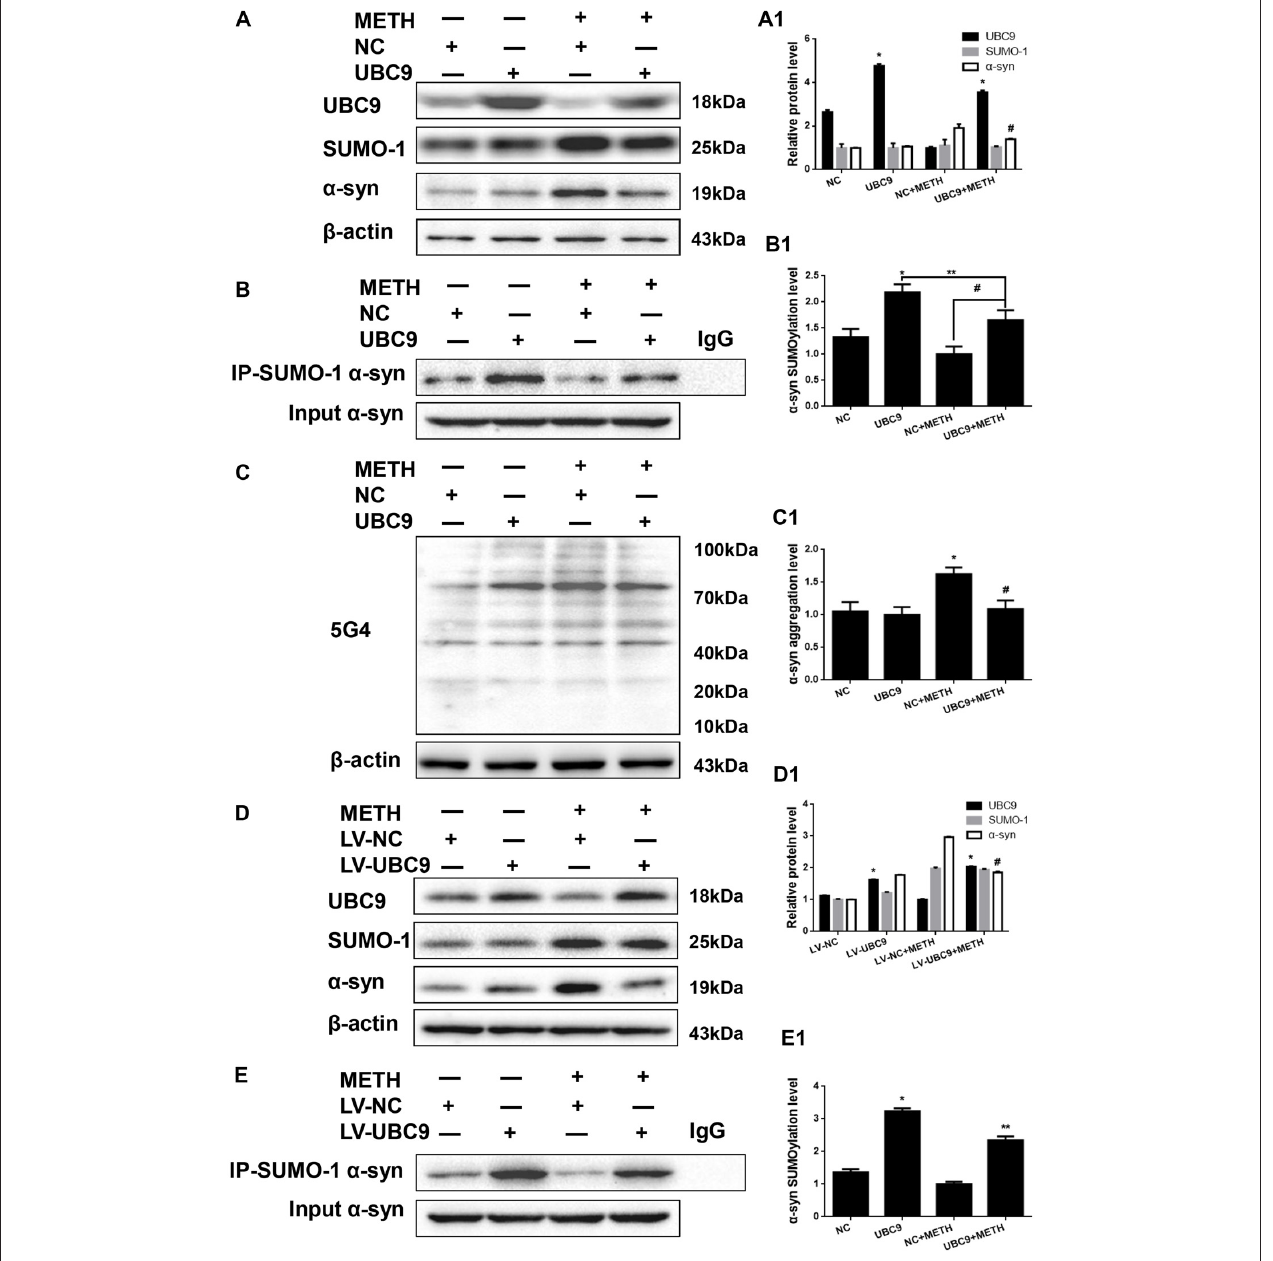
FIGURE 4 | The level of SUMOylated α -syn in METH-treated cells increases when UBC9 is overexpressed. SH-SY5Y cells (A–C,A1–C1) and primary cultured neurons (D,E,D1,E1) were transfected with pcDNA3.1-NC or pcDNA3.1-UBC9 and LV-NC or LV-UBC9, respectively. Cells were treated with or without METH. Then, the cells were immunoprecipitated with an anti-SUMO-1 antibody, followed by western blot with an anti- α -syn antibody. Cells immunoprecipitated with IgG were used as a negative control. Western blot (A–E) and quantitative analyses (A1–E1) were performed to evaluate the efficiency of UBC9 overexpression, the expression of SUMO-1, and the expression, aggregation and SUMOylation of α -syn. β -Actin was used as a loading control. ∗ p < 0.05 compared with the NC group. ∗∗ p < 0.05 compared with the LV-UBC group. # p < 0.05 compared with the METH-treated NC group. The data were analyzed using one-way ANOVA followed by LSD post hoc